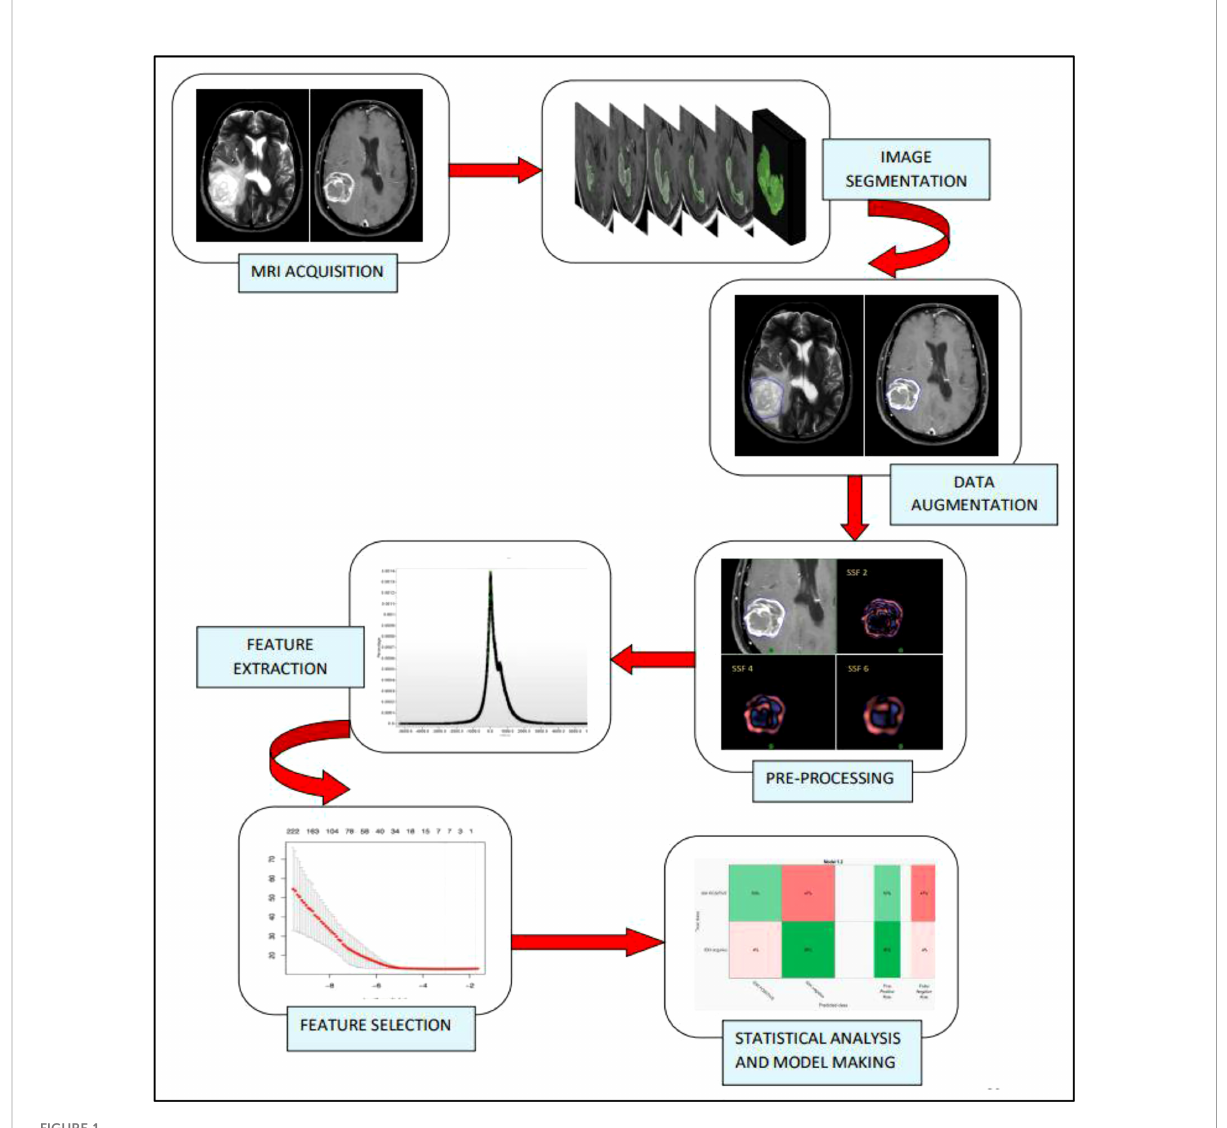
FIGURE 1 Radiomics study fl ow. The radiomic work fl ow involves MR brain imaging and data acquisition, followed by slice by slice image segmentation, data augmentation by single slice multiple sampling technique, Image pre-processing by spatial scale fi lters which involve the use of LoG (Laplacian of Gaussian) bandpass fi lter, extraction of fi rst order, and second-order features from the texture analysis software, feature selection using LASSO regression and statistical analysis and model development using Support Vector Machine (SVM) and a 10-fold cross-validation